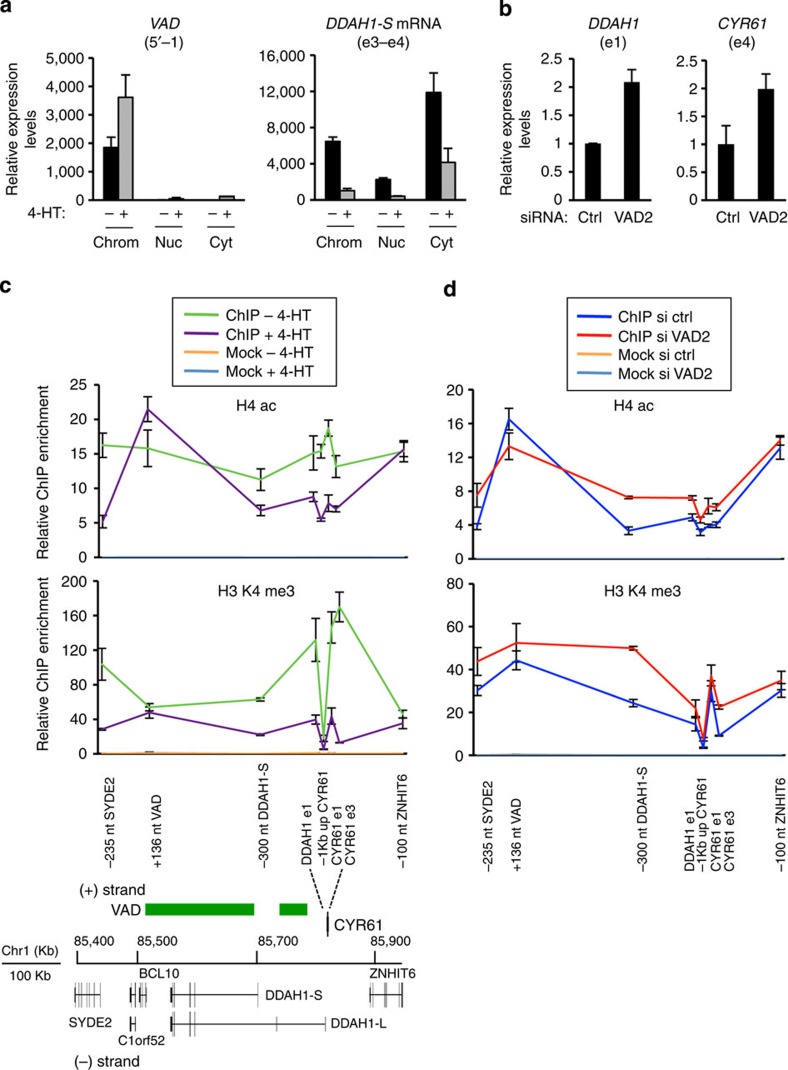
VAD regulates chromatin structure in cis.(a) WI38 hTERT RAF1-ER cells were induced to senescence for 72 h, or not, as indicated, and total RNA was then prepared from the cytoplasm (Cyt), the soluble nuclear fraction (Nuc) or the insoluble pellet (Chrom). The amount of the indicated RNA in the various fractions was analysed by qRT–PCR and calculated as described in the Methods. One representative experiment out of three is shown (mean and s.d. from the qPCR sample triplicates). VAD expression was assessed with VAD-5′-1 primers. (b) Senescent WI38 hTERT RAF1-ER cells were transfected by the indicated siRNA and subjected to run-on experiments analysed using the indicated primers. A representative experiment out of two is shown (mean and s.d. from the qPCR sample triplicates, relative to GAPDH and normalized to 1 in siRNA control). (c) WI38 hTERT RAF1-ER cells were induced to senescence for 72 h, or not, as indicated, then subjected to a ChIP assay using antibodies against acetylated histone H4 (H4ac), trimethylated lysine 4 of histone H3 (H3 K4me3) or no antibody (Mock) as a control. The amount of the indicated sequences was then quantified by qPCR and calculated relative to the input DNA. For each indicated sequence, the enrichment of the ChIP H4ac or H3 K4me3 was normalized to the enrichment of H3. The ratio between the indicated sequence enrichment and a control sequence (U6) was then performed. A schematic representation of the VAD locus with neighbouring genes (RefSeq hg18) is shown below the graphs. One representative experiment out of two or three is shown (mean and s.d. from the qPCR sample triplicates). (d) Senescent WI38 hTERT RAF1-ER cells were transfected by the indicated siRNA and subjected to a ChIP assay using a H3 K4me3 or H4ac antibodies. The indicated sequences were analyzed as in c. A representative experiment out of three is shown (mean and s.d. from the qPCR sample triplicates).